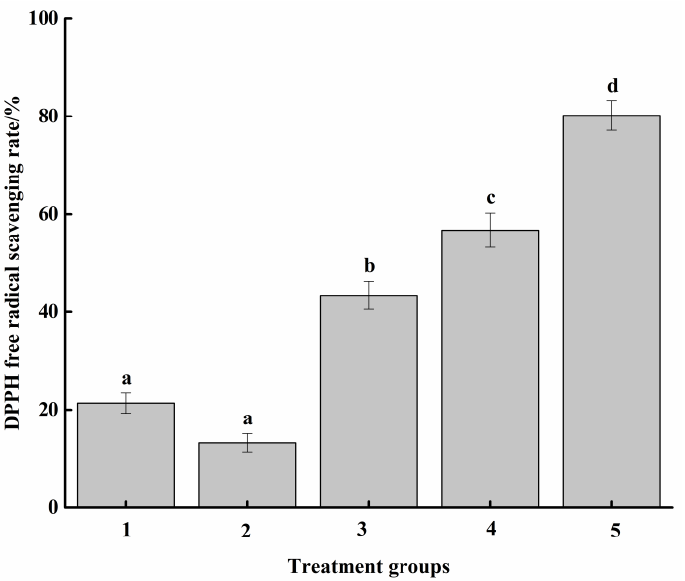
Figure 3. Scavenging ability of DPPH free radical. Group 1: Protein hydrolysate of grass carp waste. Group 2: Enzymatic hydrolysis solution of grass carp waste (without adding cysteine hydrochloride and glucose). Group 3: Self-made cat food attractant produced by Maillard reaction. Group 4: Commercial cat food attractant. Group 5: AA solution (0.2 mg/mL). Different letters between groups represent significant differences ( p < 0.05).